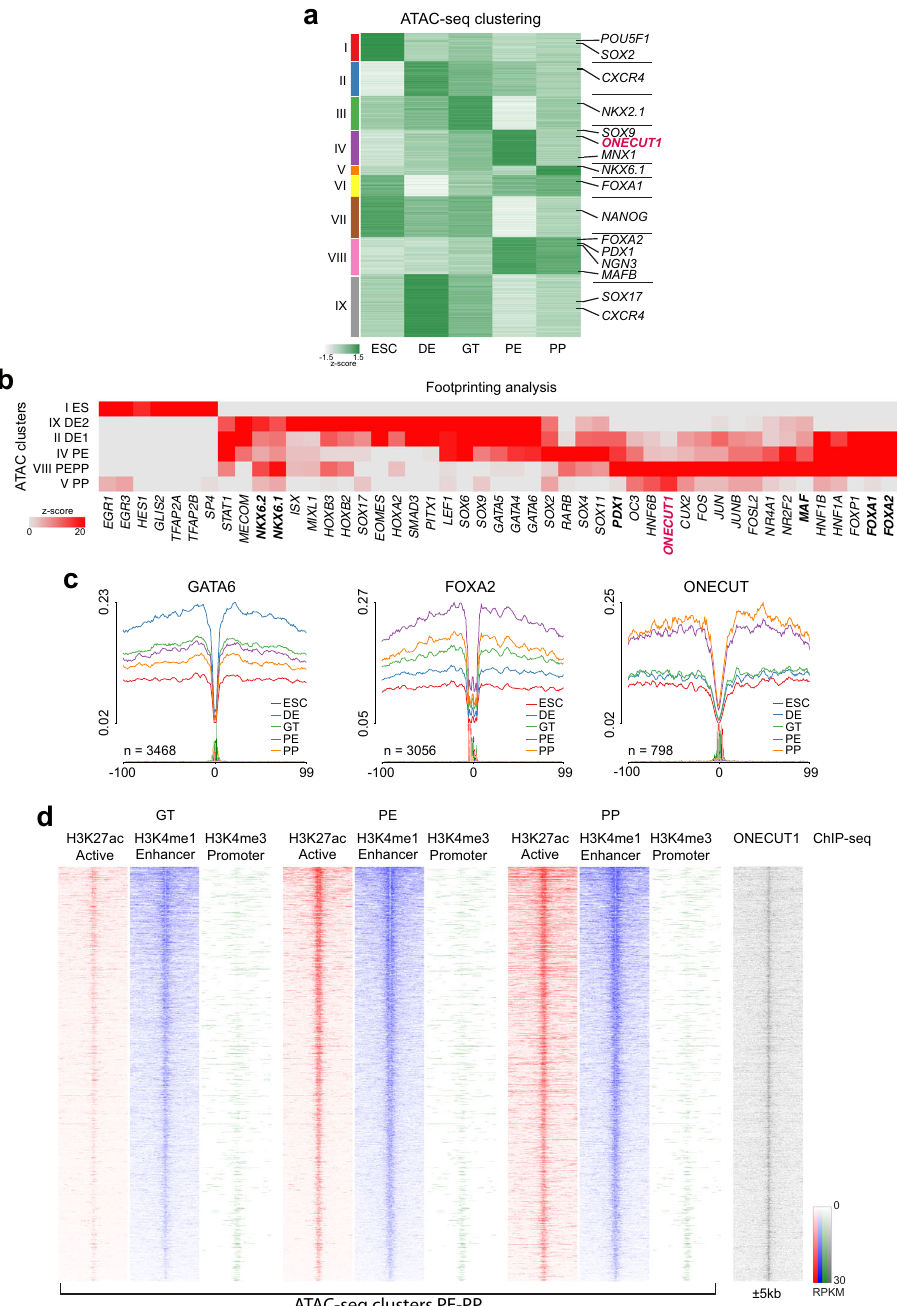
Fig. 2 ONECUT1 binding and chromatin opening is relevant for pancreas development. a Fuzzy c-means clustering of the differential open chromatin peaks (ATAC-seq) during pancreatic differentiation of HUES8 cells. b TF binding motif enrichment at distinct open chromatin clusters of ATAC-seq. c Average chromatin accessibility pro fi les around footprint-supported bindings sites of selected TFs. d Heatmap ChIP-seq signals ( + / − 5 kb of peak center) of H3K4me1, H3K4me3, and H3K27ac at ATAC-seq peaks from cluster PE-PP (VIII; clustering is shown in Fig. 2a). Peaks are ordered by the decrease in the H3K4me1 mark at PE stage. We also depict ONECUT1 ChIP-seq signals (PP stage) in the vicinity of the peak ( + / − 5